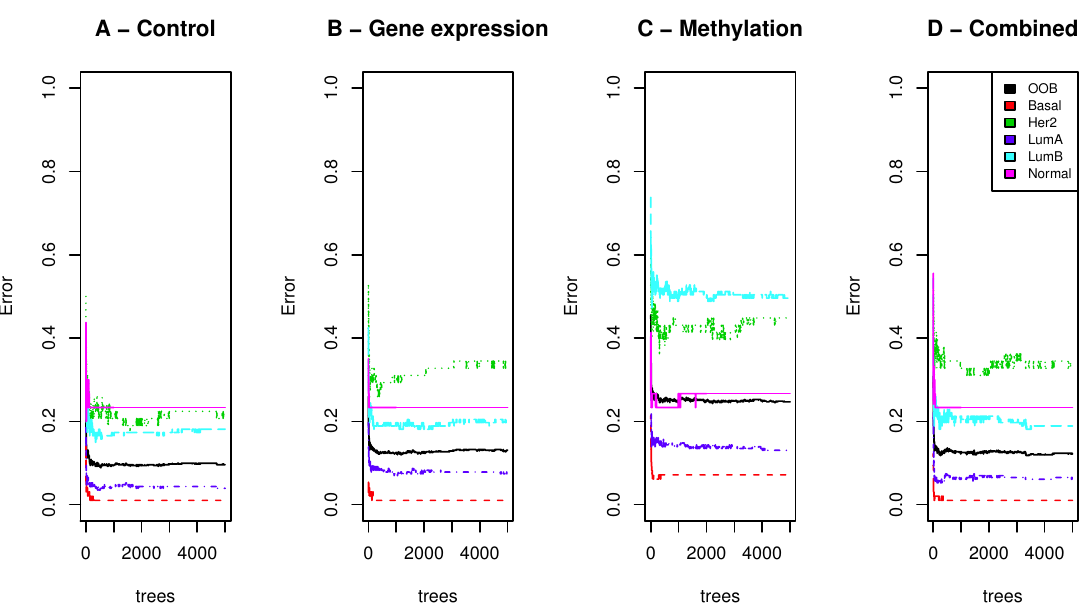
Figure 3: The classification and out of bag error (OOB) of each subtype for the control model (A), gene expression model (B), methylation model (C) and the combined model (D) depending on the number of trees already created by the random forest